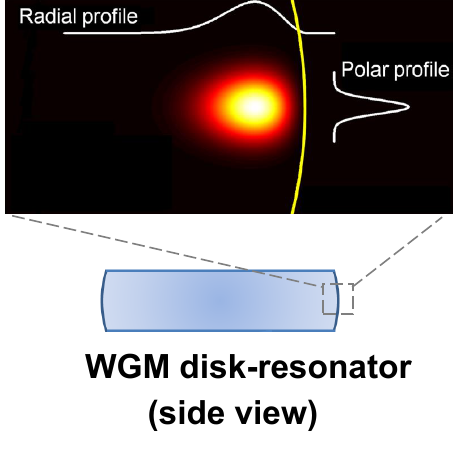
Figure 1: (Color online) Schematical representation of a torus-like eigenmode in a crystalline WGM disk-resonator (fundamental eigen- mode with a single extremum in the radial and polar directions). This eigenmode can trap the intra-cavity photons for a significantly long time. Both the strong-field confinement (or equivalently, small mode volume) and the long photon lifetime (typically, ∼ 1 µ s) con- tribute to enhance the nonlinear interaction between the intra- cavity photons. Such resonators typically have a Q -factor of one billion at 1550 nm.